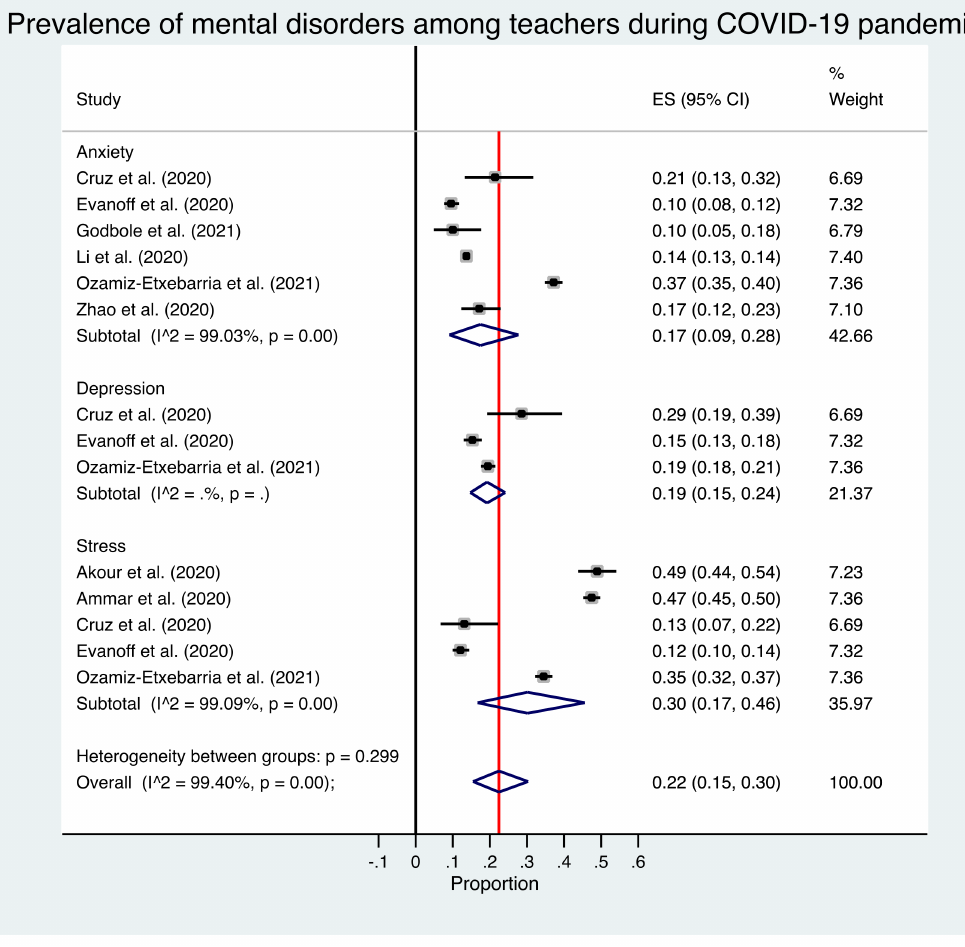
Figure 2. Forest plot for the prevalence of mental disorders among